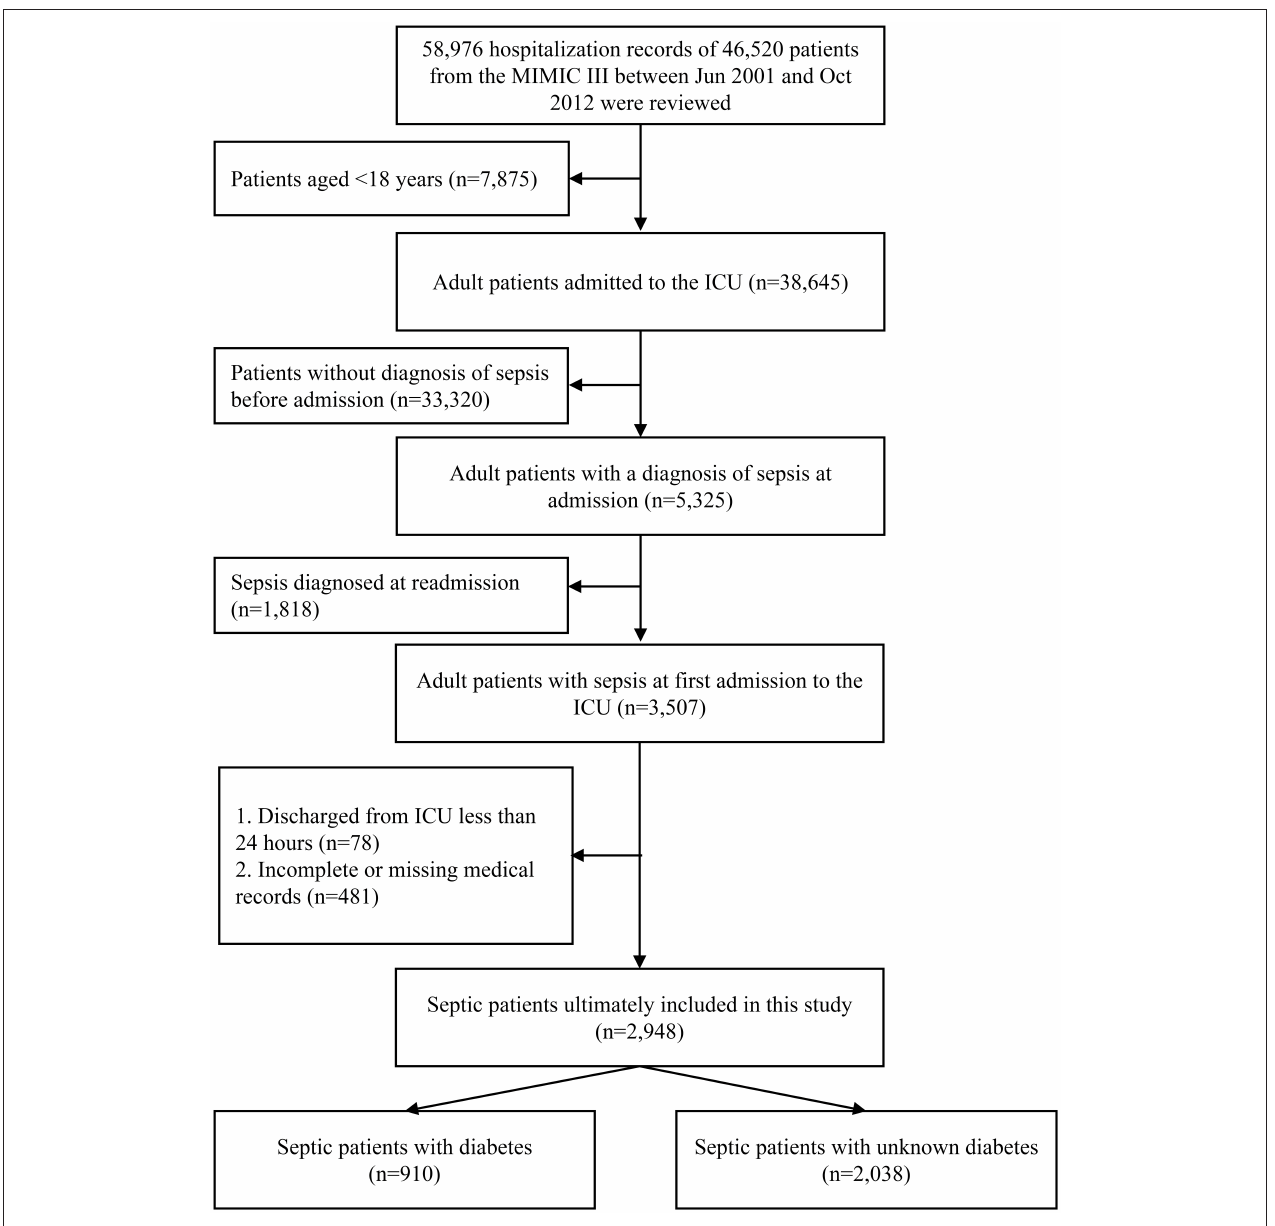
FIGURE 1 | The patient selection process in the MIMIC III database. MIMIC III, the Medical Information Mart for Intensive Care III.